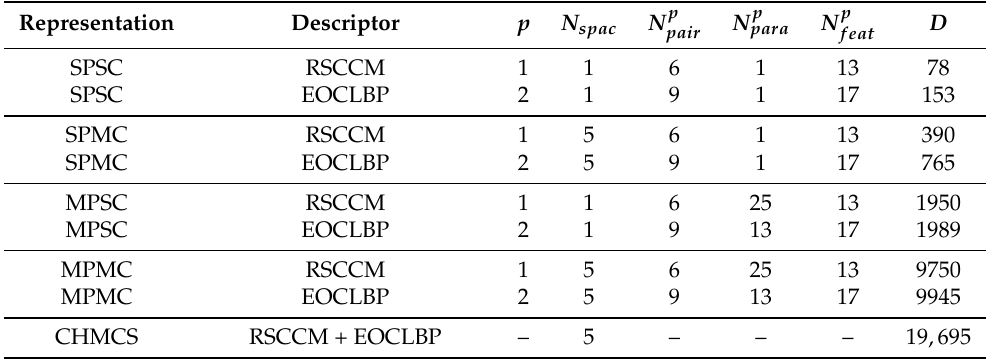
Table 3. Color texture representations where N spac is the number of considered color spaces, N p the number of color component pairs considered in each color space, N p para is the number of parameter combinations, N p is the number of color texture features extracted from each configuration of the feat p th descriptor, and D is the total number of color texture